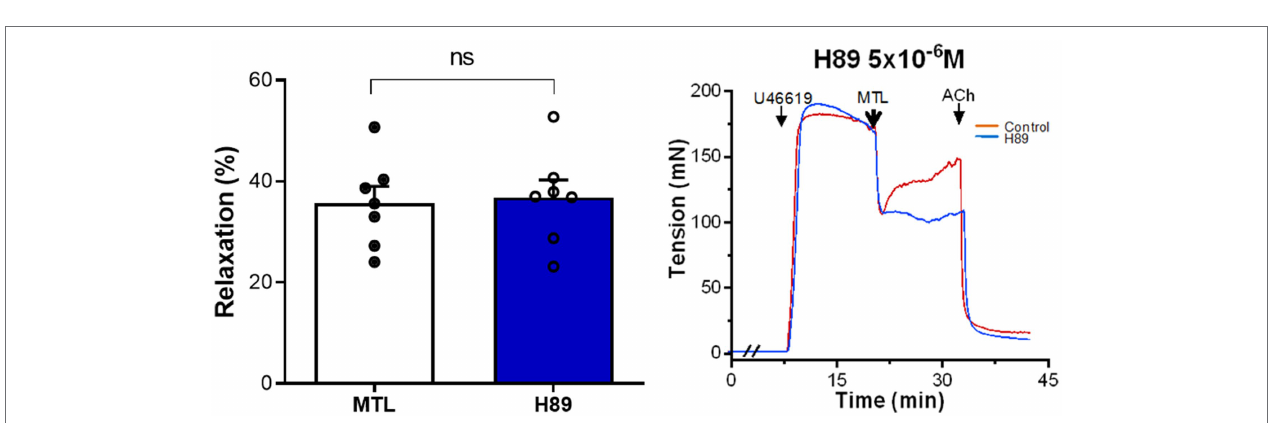
FIGURE 5 | Role of the AC-PKA pathway on motilin-induced vasorelaxation. Effect of H89 (5 × 10 − 6 M) on LGA relaxation induced by motilin (9 × 10 − 8 M) and corresponding representative traces. Values are means ± SEM ( n = 7). ns, non-significant at p > 0.05 by paired t -test. The double slash (//) indicates pretreatment with H89 before incubation with U46619. The arrows indicate the time of drug administration. AC, adenylyl cyclase; ACh, acetylcholine; H89, PKA inhibitor; LGA, left gastric artery; MTL, motilin; PKA, protein kinase A; SEM, standard error of the mean; and U46619, thromboxane A 2 receptor